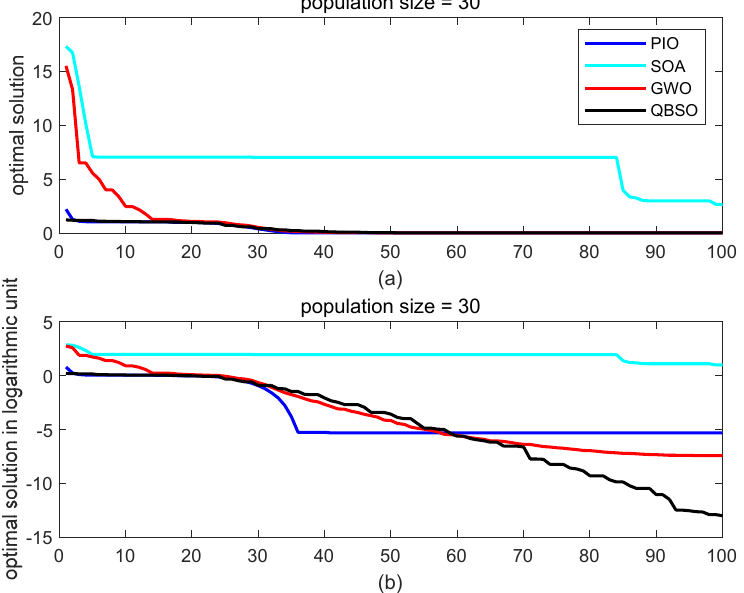
Figure 4. Convergence of the optimal solution of the Griewank function at different iterations. ( a ) Optimal solution in natural number unit; ( b ) optimal solution in logarithmic unit.